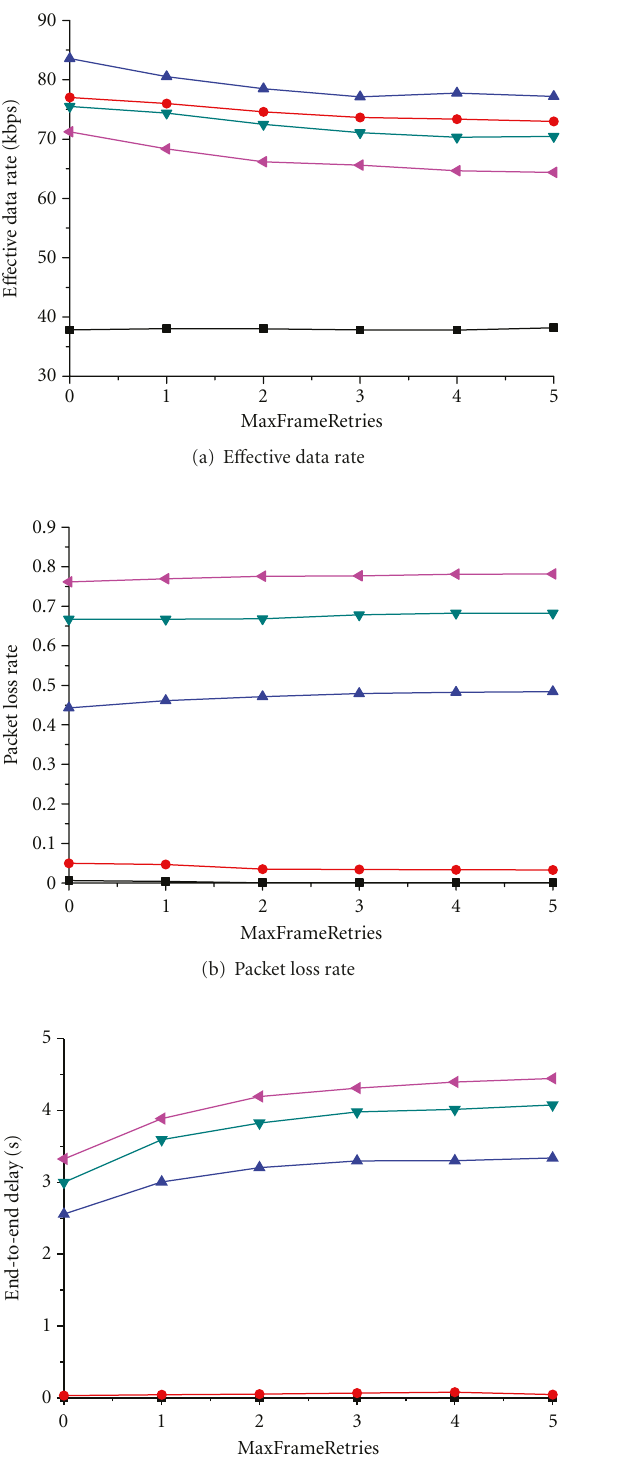
Figure 8: QoS with di ff erent MaxNB values in beacon-enabled